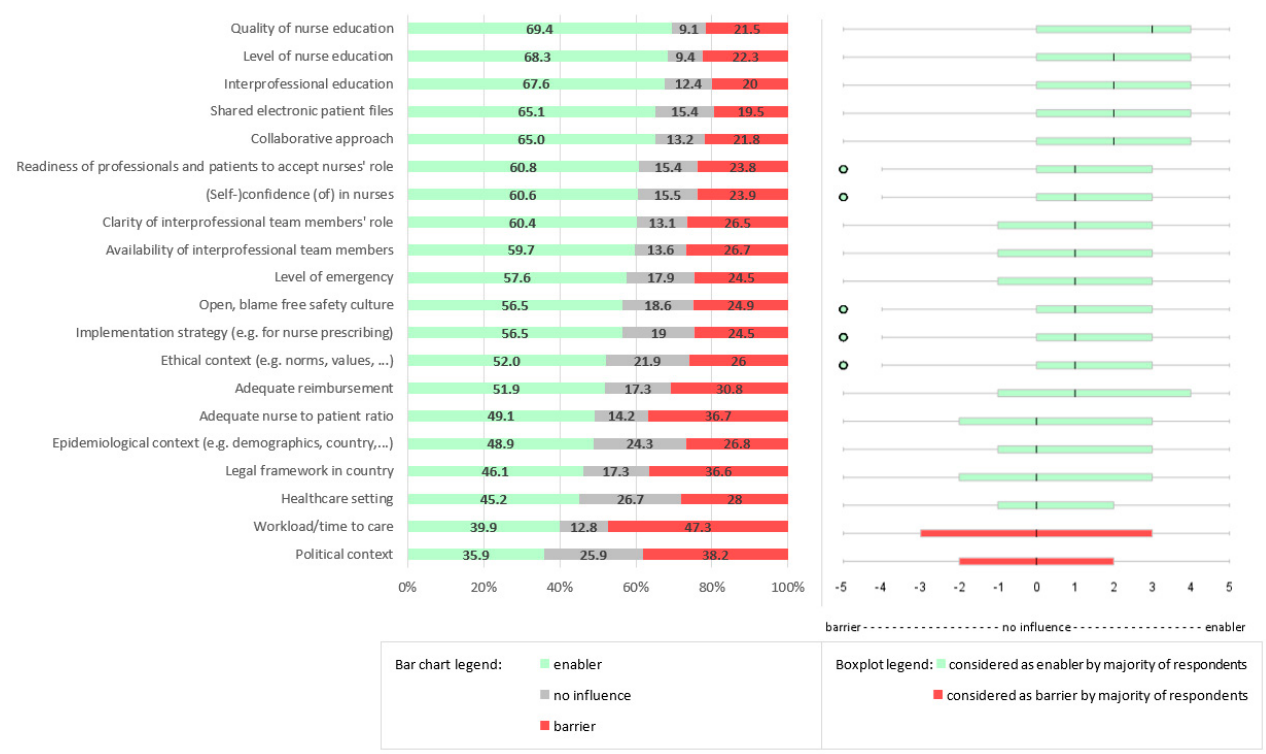
Figure 5. Bar charts (left side) for the percentage of respondents considering 20 contextual factors as barriers or enablers of nurse’ role in interprofessional pharmaceutical care, supplemented with boxplots (right side) for the scores on a 10-point scale from − 5 (great barrier) to +5 (great enabler) ( n = 1005).